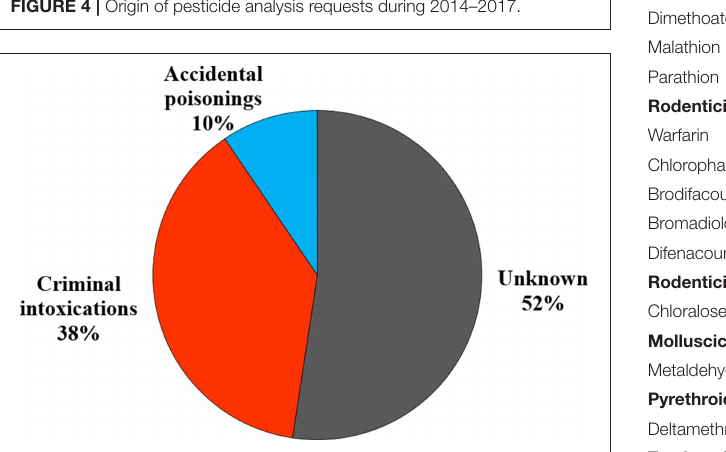
FIGURE 5 | Circumstances of animal poisoning.